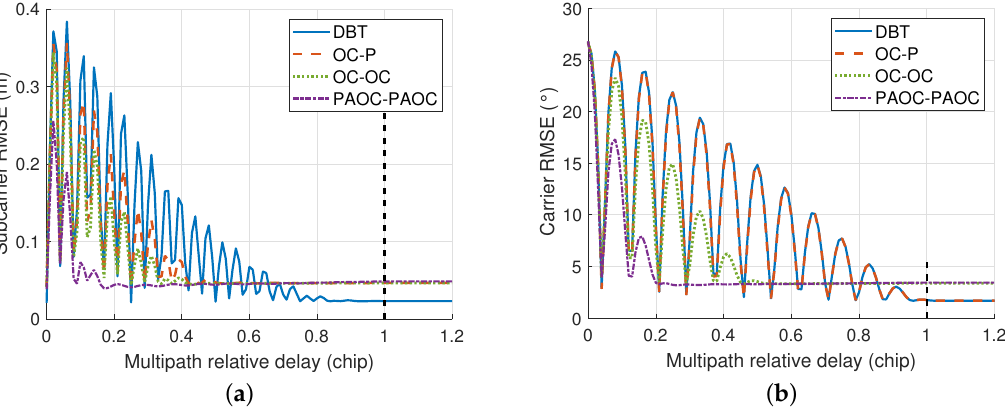
Figure 11. RMSE envelop of various methods for the BOC(15, 2.5) signal, where the multipath relative phase is ± π /2: ( a ) subcarrier RMSE; ( b ) carrier RMSE.